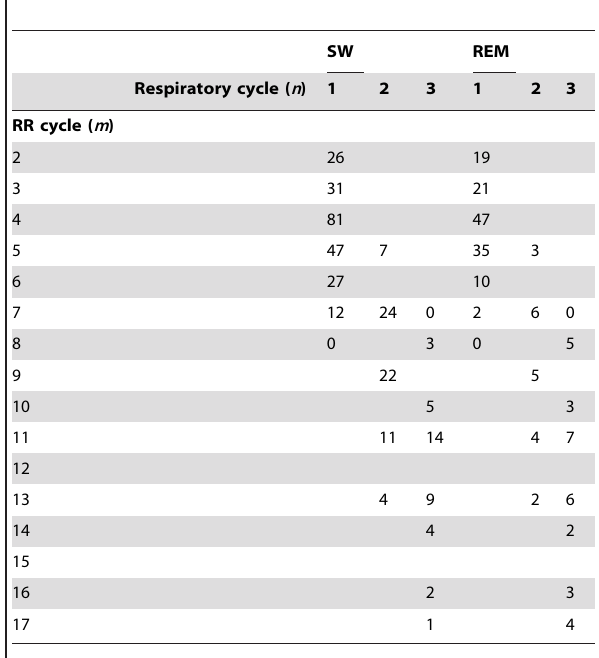
Table 3. Number of m : n coordinated epochs observed during slow-wave (SW) and rapid-eye-movement (REM) sleep.